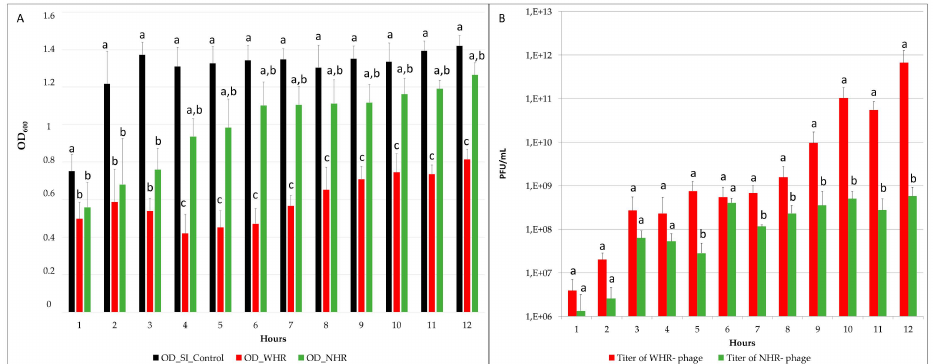
Figure 3. Graphical representation of parameters measured to compare challenge assays during the 12 h experiments. ( A ) Optical density (OD 600 ) obtained per hour of control S. Infantis, S. Infantis exposed to WHR phages, and S. Infantis exposed to NHR phages. A statistical analysis was performed to compare the hourly di ff erences between OD control, WHR, and NHR through Kruskal Wallis, p < 0.05). ( B ) Viral titer obtained per hour on challenge with WHR and NHR phages, expressed as PFU / mL. The di ff erences in phage titer were analyzed through (ANOVA, p < 0.05). Standard deviation was calculated between the four replicates per hour, for each variable, and statistically significant di ff erences ( p < 0.05) are indicated by di ff erent